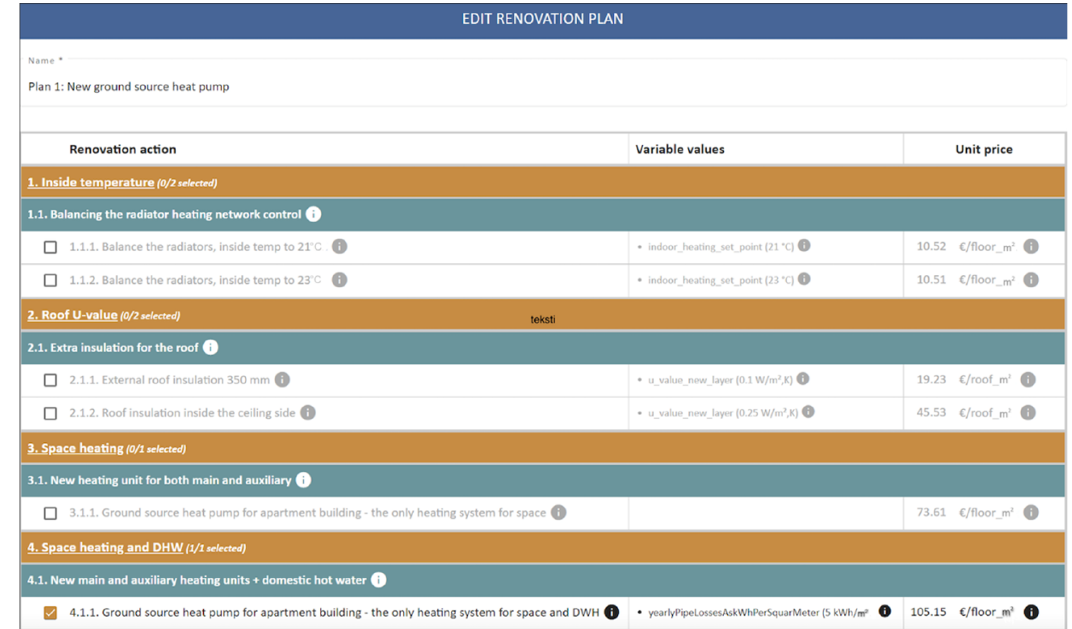
Figure 7. Retrofitting tool GUI: Step 4—Select/Edit retrofitting actions.